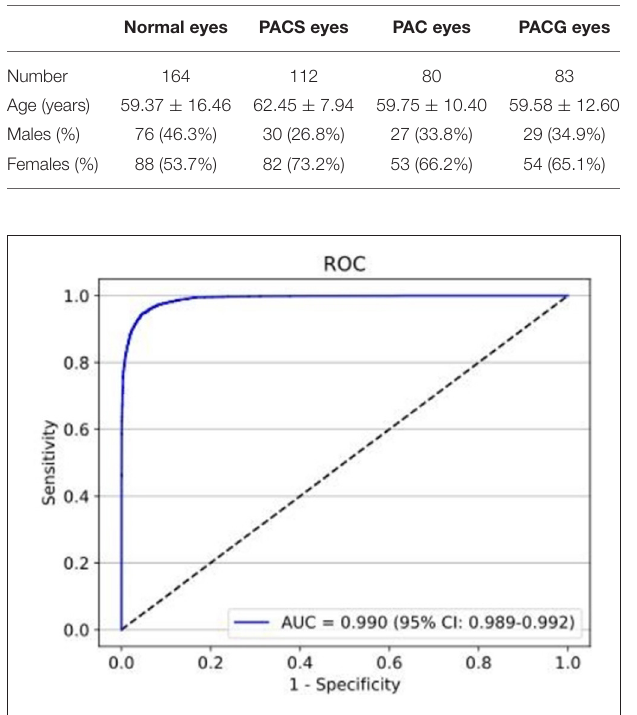
FIGURE 5 | The test set performance for the detection of static angle closure and open angle achieved an AUC of 0.990 with a sensitivity of 0.9465 and specificity of 0.9533.